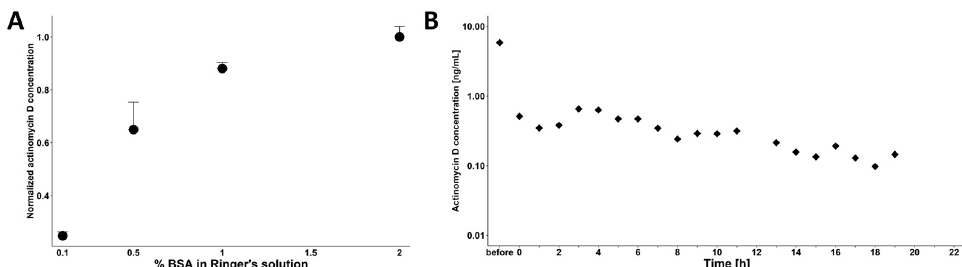
Figure 4. ( A ) Actinomycin D showed nonspecific binding to the microdialysate equipment, which can be reduced by adding bovine serum albumin to the Ringer solution. ( B ) Actinomycin D concentration detected in in vivo cerebral microdialysis samples of a non-dosed mouse after prior in vitro calibration of the microdialysis probe with actinomycin D.